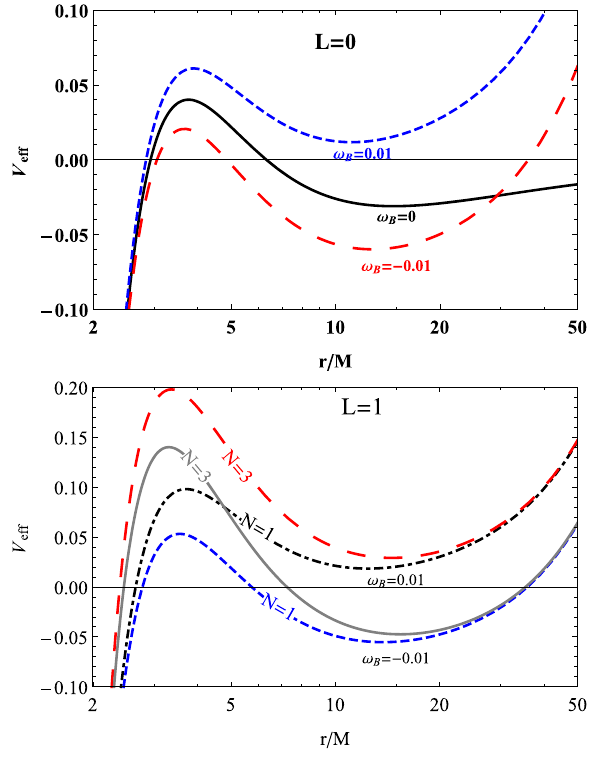
Fig. 4 Radial dependence of the effective potential of a charged par- ticle for different values of the conformal, scale, and magnetic field parameters